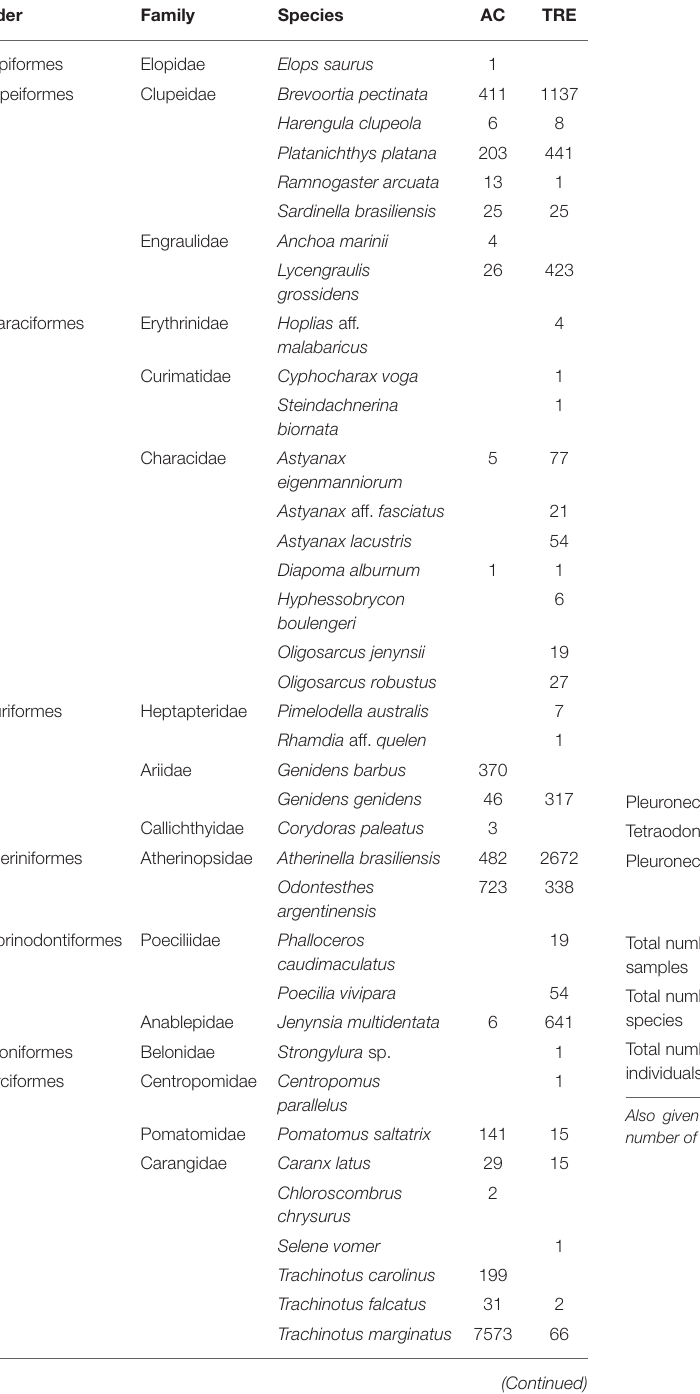
TABLE A1 | Composition (total number of individuals collected) of the species registered for marine adjacent coastal area (AC) and Tramandaí River estuary (TRE) by order, family and